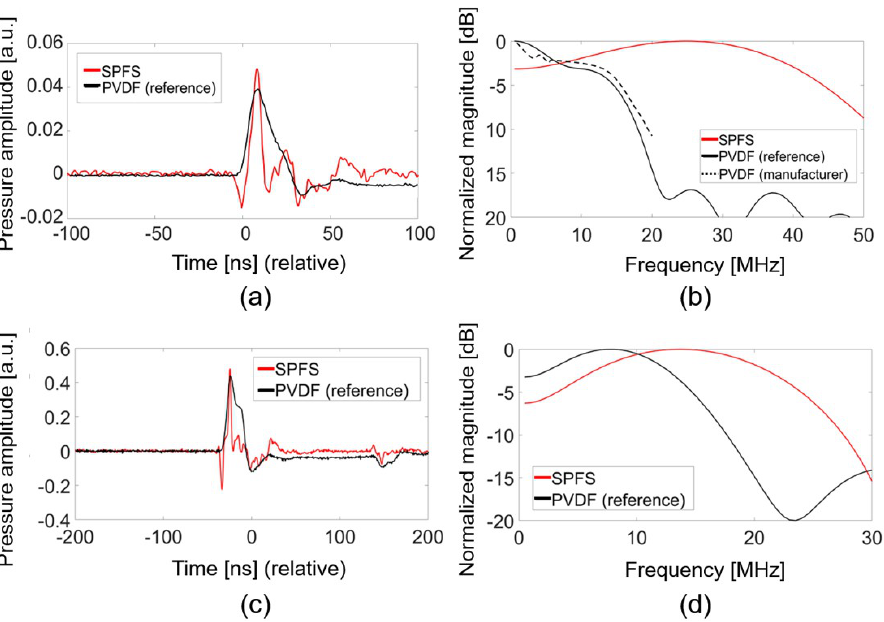
Figure 4. Acoustic signal waveforms and frequency spectra: ( a,b ) from the Cr film used as a source; ( c,d ) from the CNT-PDMS transmitter as a source.